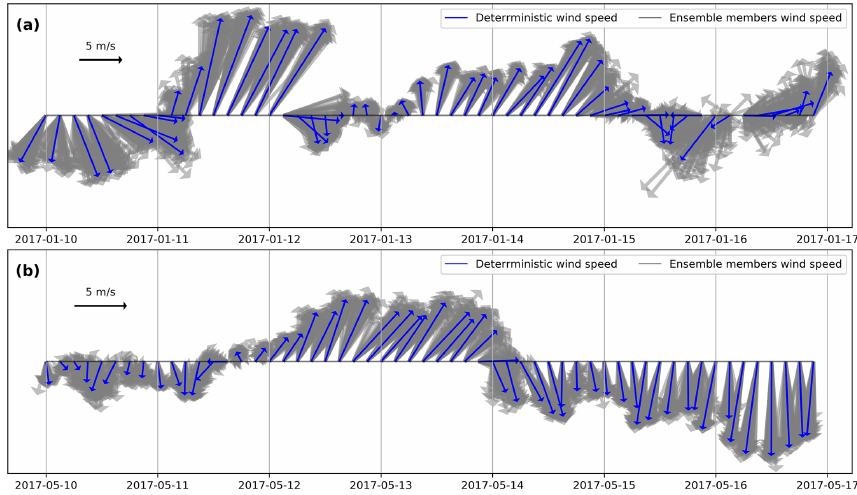
Figure 4. Wind stick vector plots of velocity and direction at Kafireas Strait for the 7d deterministic simulation (blue arrows) and the 50 ensemble members (gray arrows): (a) winter and (b) spring. Reference vector: 5m/s.